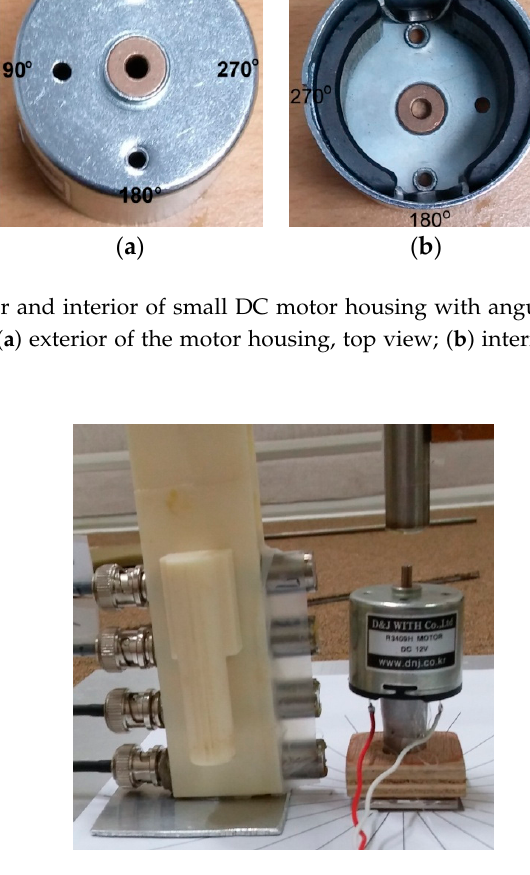
Figure 3. A small DC motor and measurement microphones positioned in the vicinity of the motor. A stationary reference microphone positioned above the center of the motor shaft, and scanning microphones located in parallel to the axial direction of the motor.